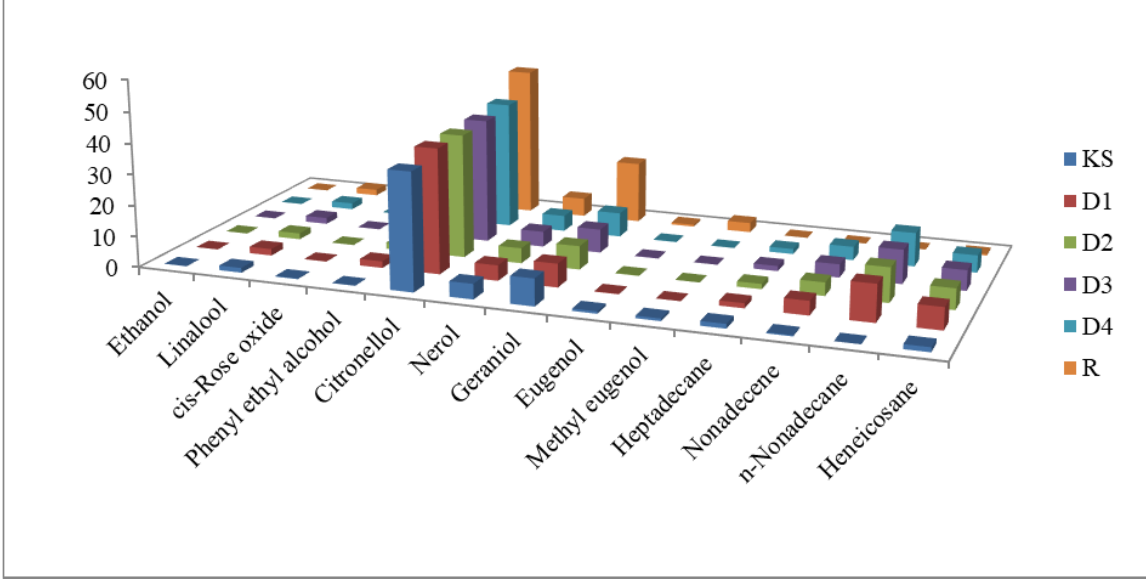
Figure 3. The most important Chinese rose oil components, monitored by the ISO, as determined by GC-FID.